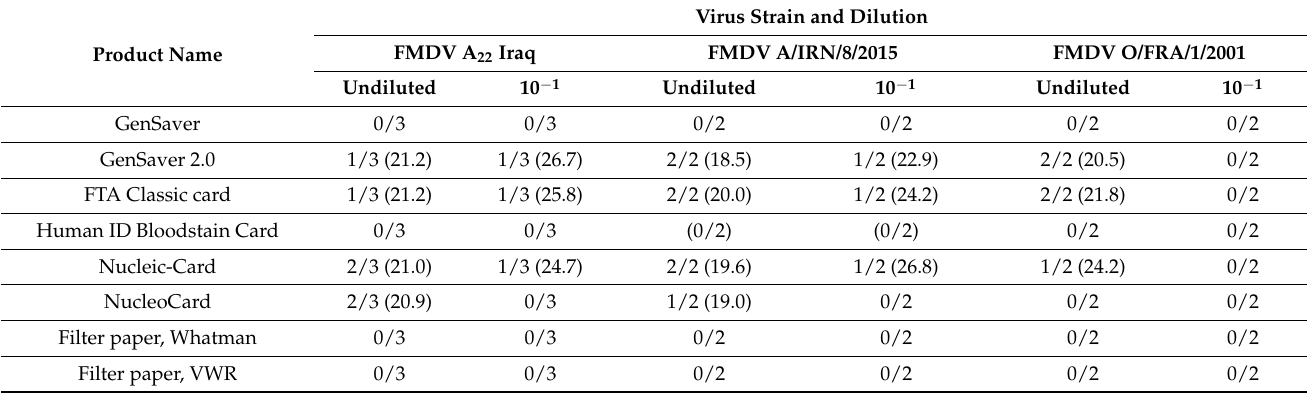
Table 3. Transfection results by card or filter type, virus strain and sample dilution, showing the number of successful transfections compared to the total number of replicates. The average C q value of the samples for which the transfection was successful is given in